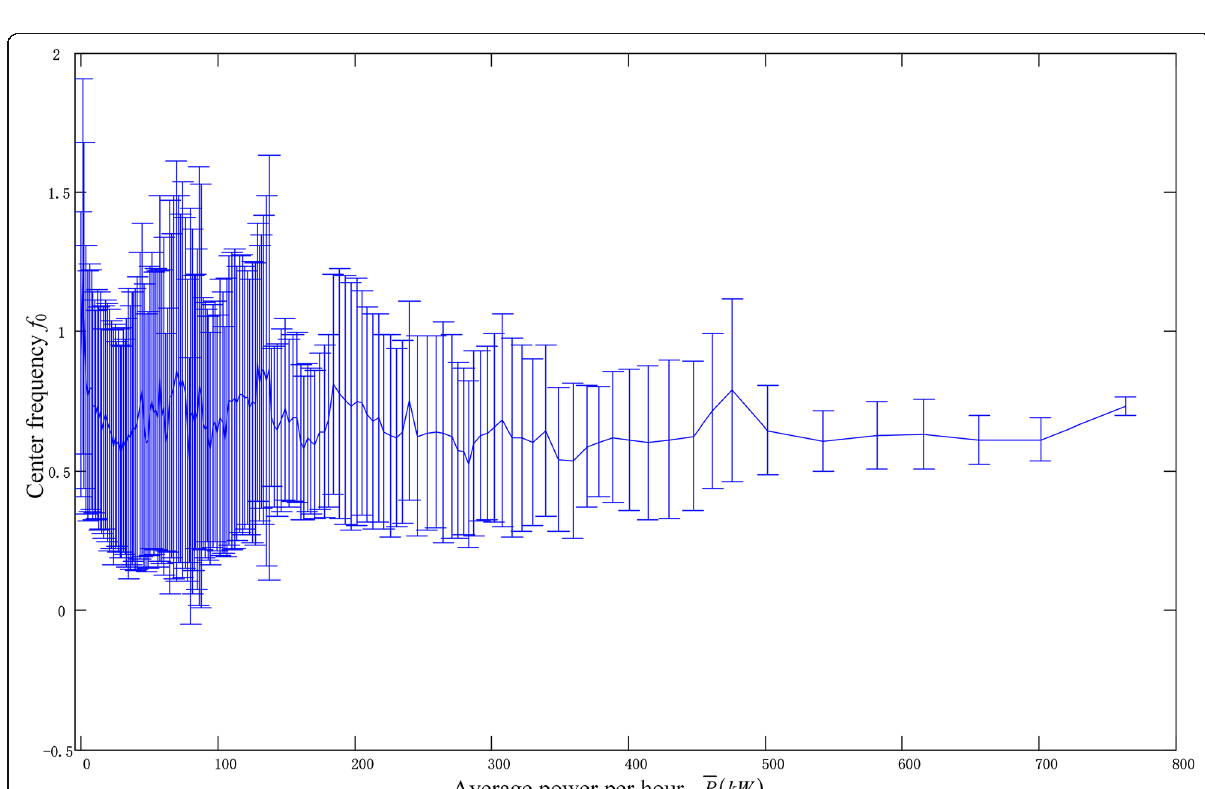
Fig. 4 Relationship between spectral characteristic and average